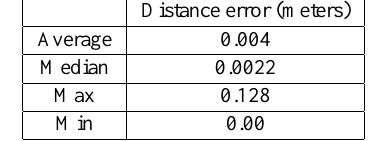
Table 3: The distribution of the distance error. Distance error (meters) Counts Rate (%) Cumulative rate (%) ∼ 0.001